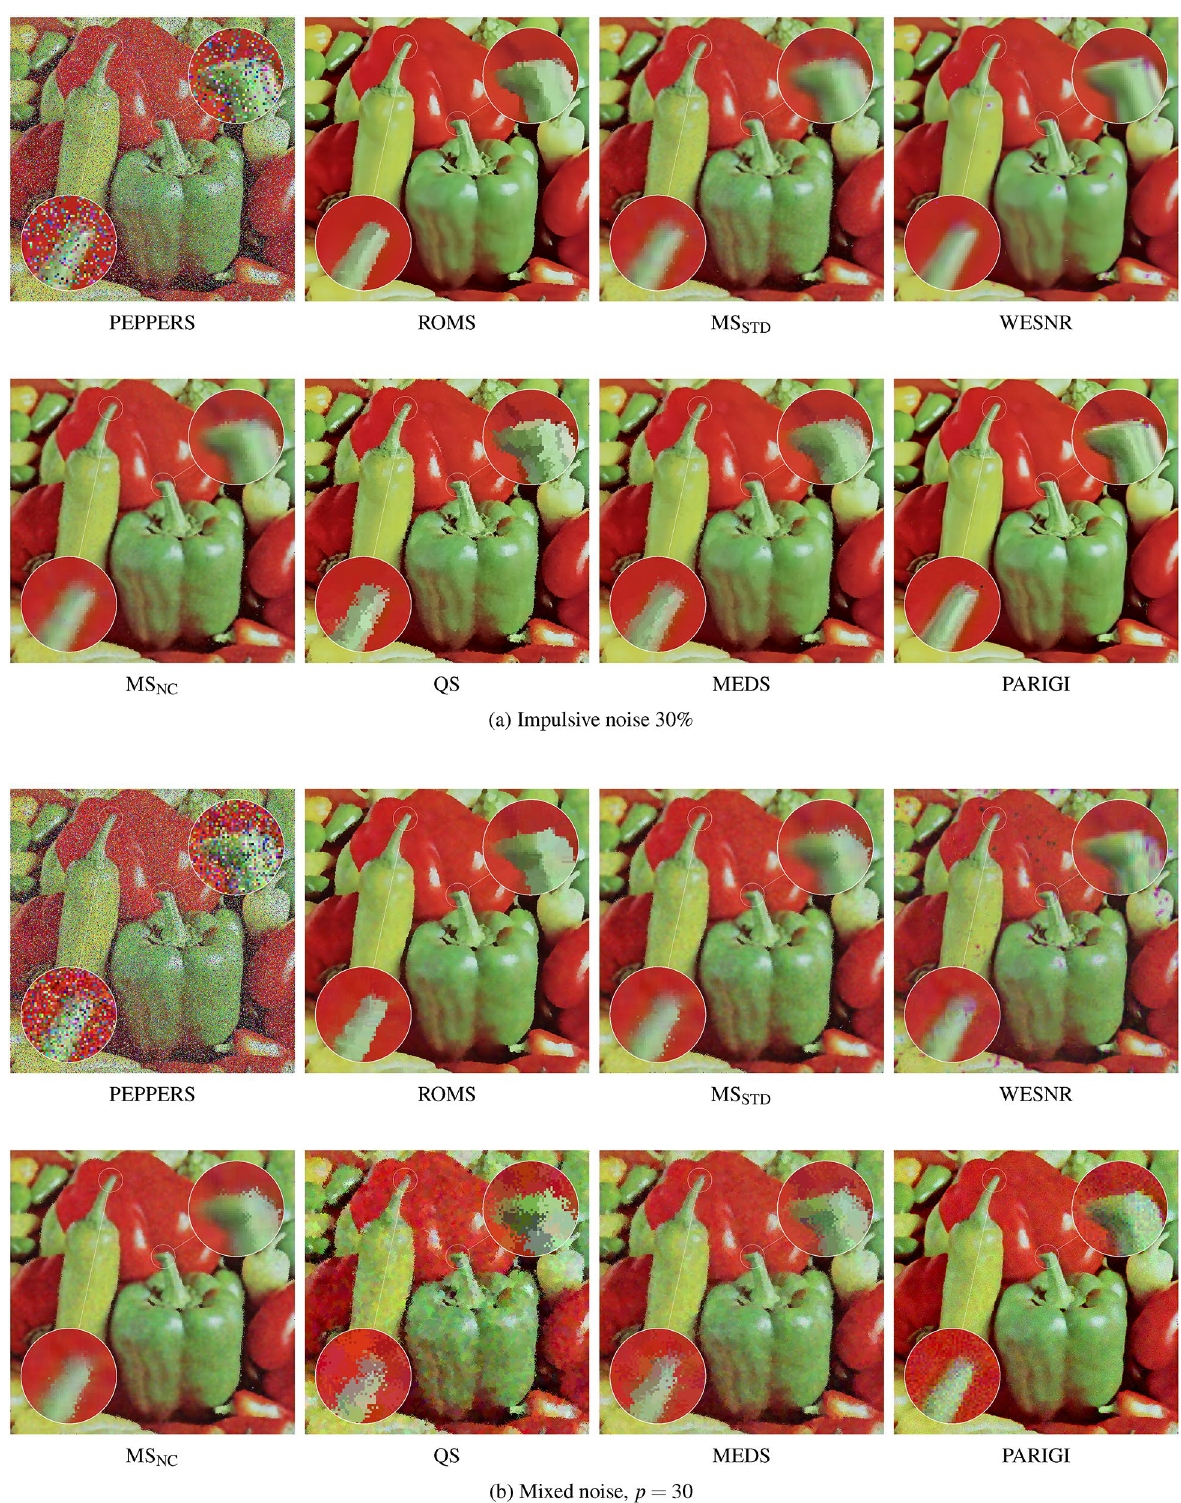
Figure 7. Efficiency comparison of the the ROMS algorithm with the competitive techniques evaluated on test image PEPPERS contaminated with impulsive noise of 30% ( a ) and with mixed noise of intensity p = 30 ( b